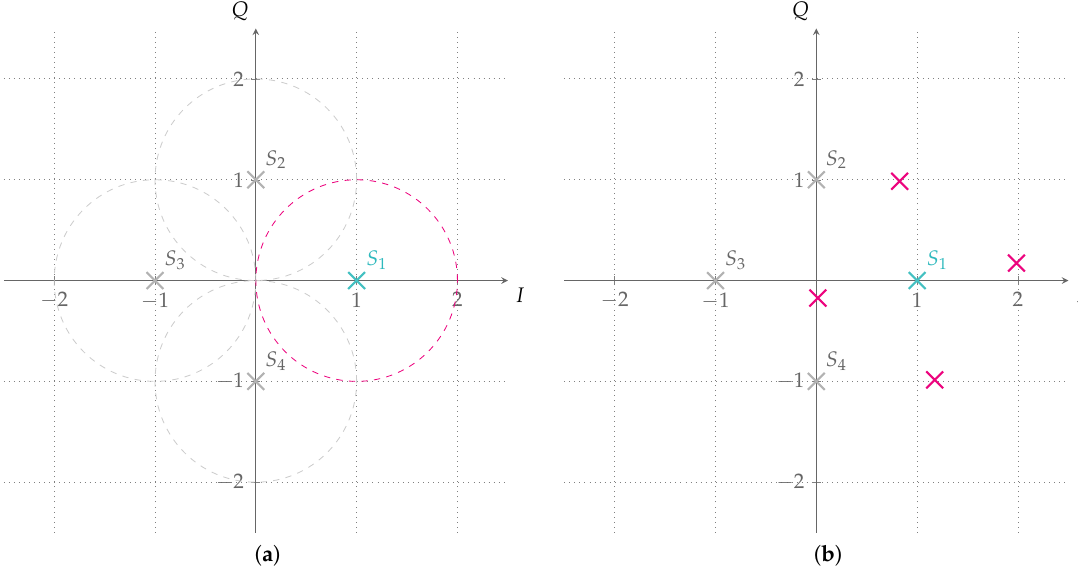
Figure 4. QPSK-modulated constellation after phase compensation at the receiver side and single symbol-synchronous interferer with the same power, relative phase shift, and no noise. ( a ) QPSK- modulated constellation after phase compensation at the receiver side. We highlight symbol S 1 = ( 1,0 ) . If the symbol is affected by QPSK-modulated interference with the same unit power, no noise, and random phase, the received symbol will lay on the red unit circle centred in ( 1,0 ) . ( b ) QPSK-modulated constellation after phase compensation at the receiver side and one QPSK-modulated interferer with the same unit power, no noise, and ∆ ϕ = 10 ◦ relative phase shift. Red crosses represent the four possible received symbols if the considered transmitted symbol was S 1 = ( 1,0 )